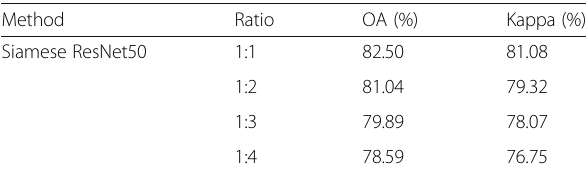
Table 1 The experiments of random rotation ratio on SIRI-WHU dataset